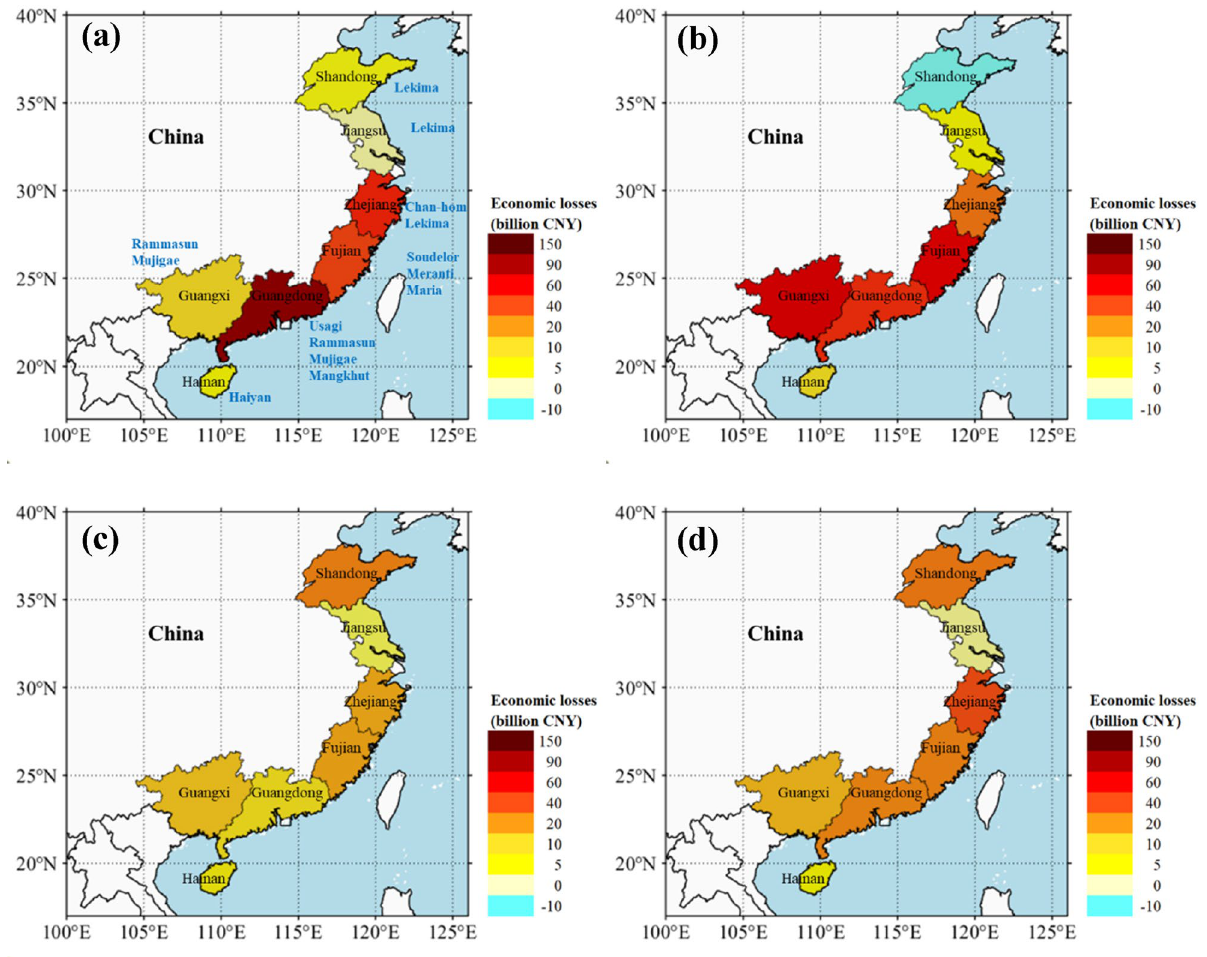
Figure 3. Estimated direct economic loss (CPI-2013 adjusted losses) of the 10 SuperTYs in historical and future climates by DNN models. (a) Direct loss estimation from historical simulation of the 10 SuperTYs. (b) Projected change of direct economic loss for CMIP5 mean RCP8.5 relative to historical estimation. (c) Projected change of direct economic loss for CMIP5 mean RCP4.5 relative to historical estimation. (d) Projected change of direct economic loss for HiFLOR RCP4.5 relative to historical estimation. Maps were generated by MATLAB R2021a (http:// www. mathw orks.